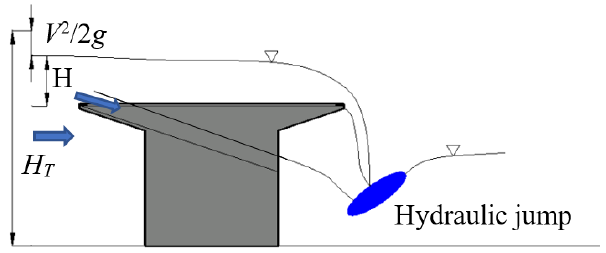
Figure 4. PK weirs under the free - flow